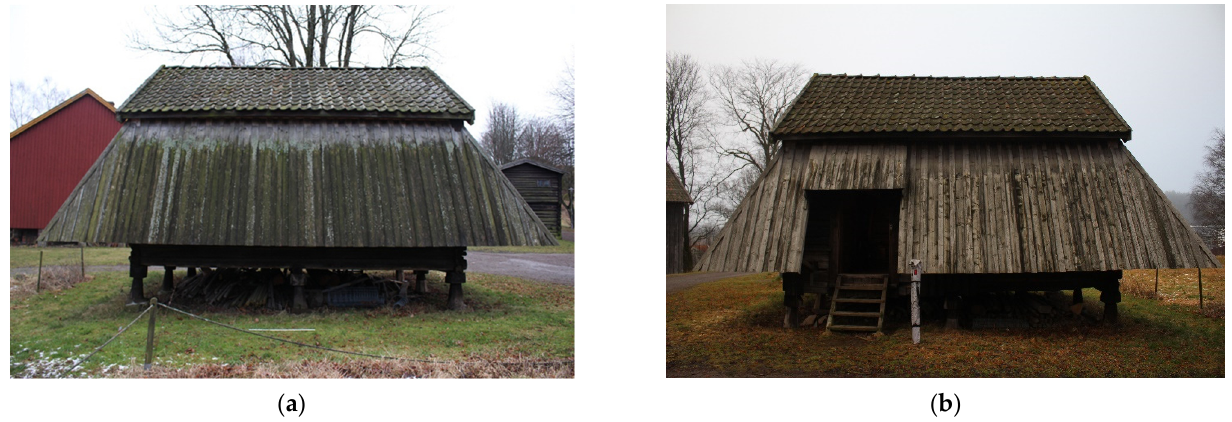
Figure 6. At the Fadum storehouse, the growth of biological organisms is more intense on ( a ) the north façade than on ( b ) the south façade.